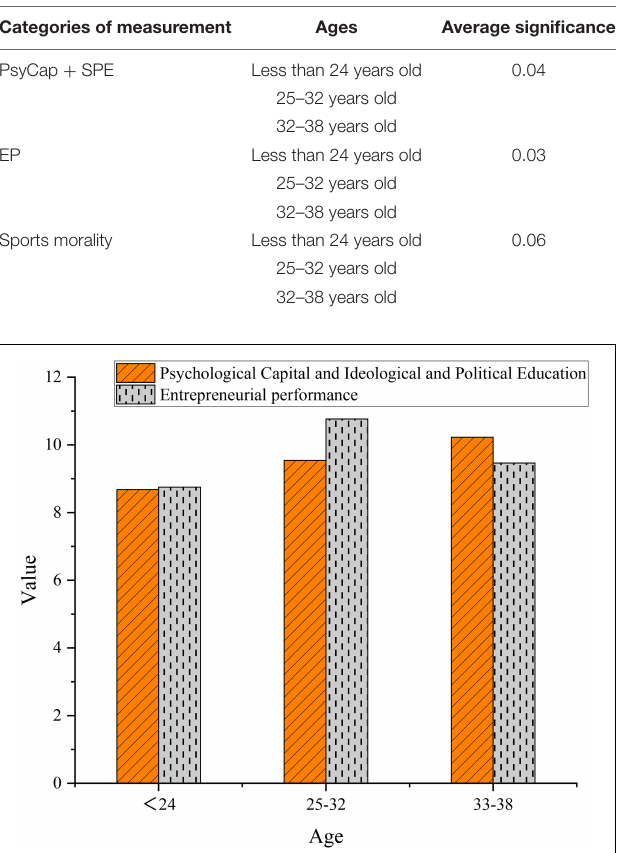
TABLE 7 | Significant difference of ages.